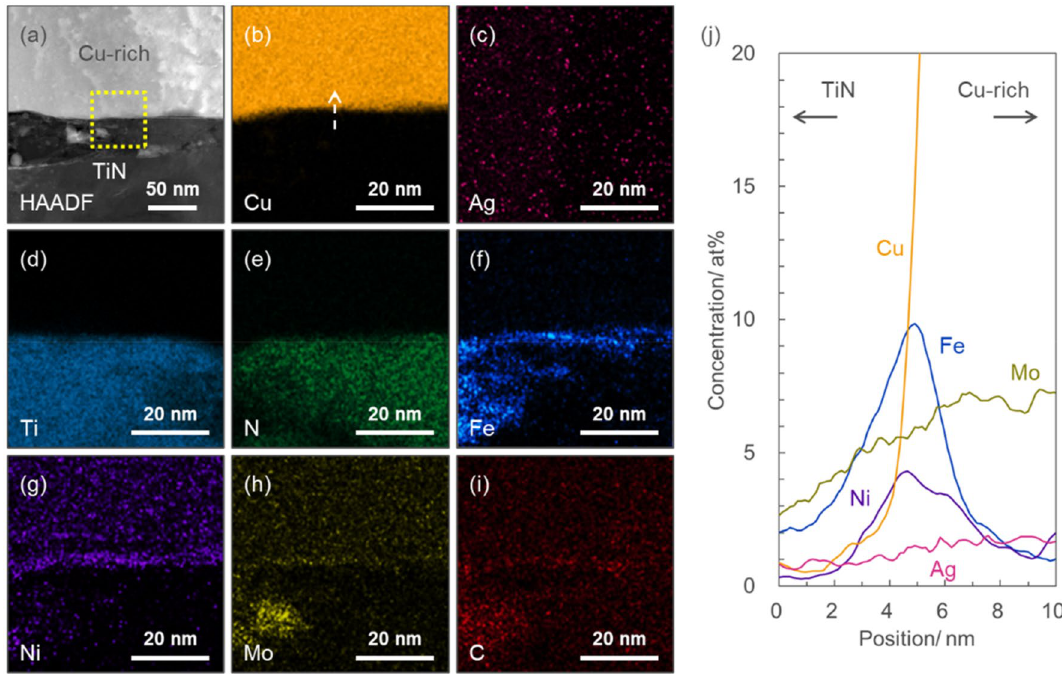
from the selected area marked in ( a ) by EDS. j Line EDS profile obtained along the white dashed arrow shown in ( b